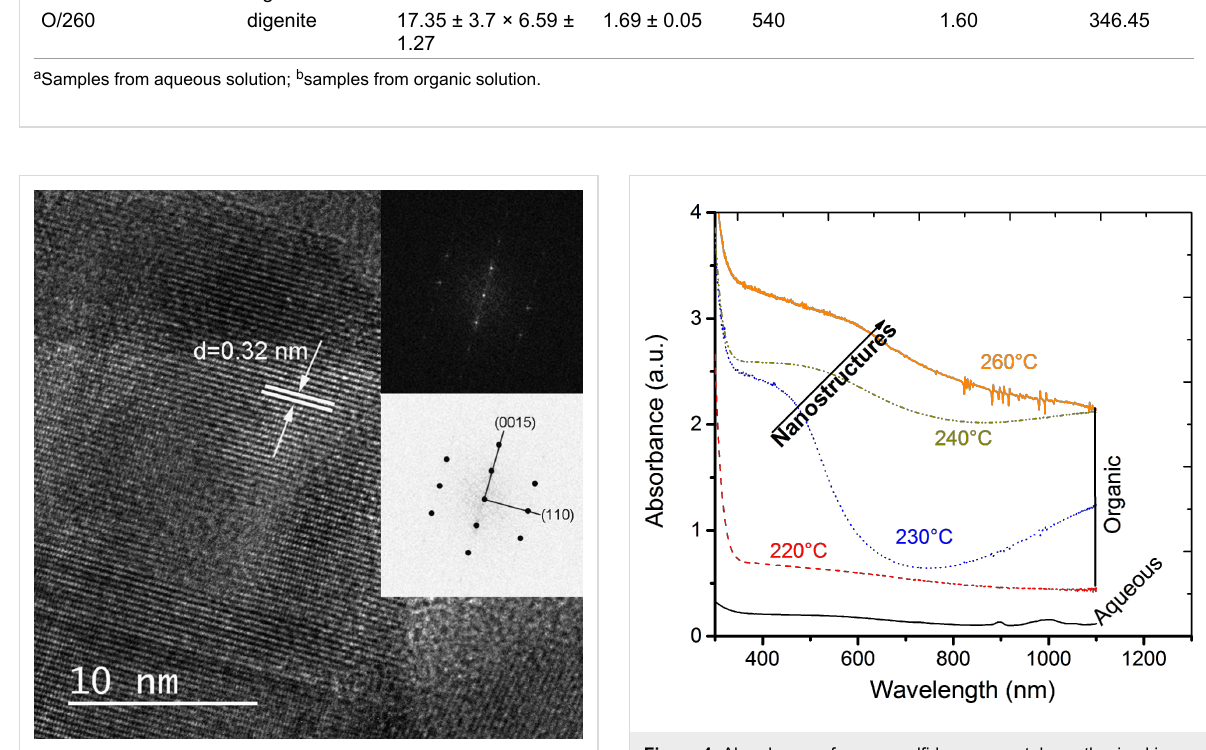
Figure 3: HRTEM image of copper sulfide obtained from synthesis in an organic solvent. The inset figures display the crystallographic planes (0015) and (110), respectively, of the digenite phase.